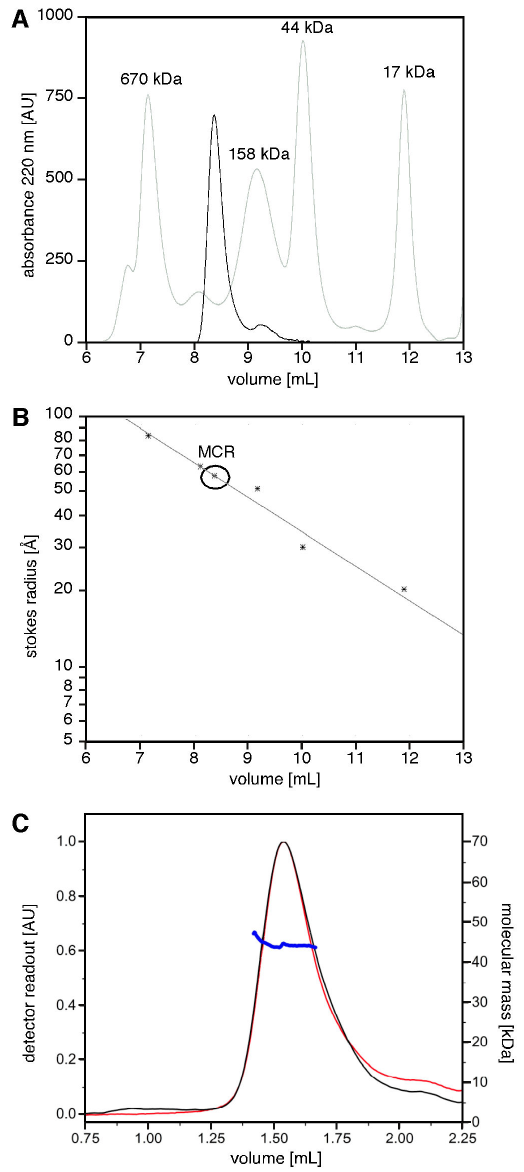
Figure 5. APC-MCR runs at a higher apparent molecular weight upon size exclusion chromatography. A , APC-MCR was applied to analytical size exclusion chromatography. MCR eluted after 8.36 min between the indicated globular size standards. By semilogarithmic fitting to the molecular weights of the standards, an apparent molecular weight of 220 kDa has been determined for APC-MCR. B , The straight line indicates a semilogarithmic fit to the known stokes radii of the indicated standard proteins. According to this analysis, MCR has a stokes radius of 5.9 nm. C , SEC-MALLS reveals that the ySUMO-APC-MCR fusion protein is monomeric. ySUMO-APC- MCR eluted as a single peak with a mass of 44.4 ± 4.0 kDa (UV absorption at 220 nm, black, arbitrary units; differential refractive index, red, arbitrary units; Molecular mass, blue, kDa).